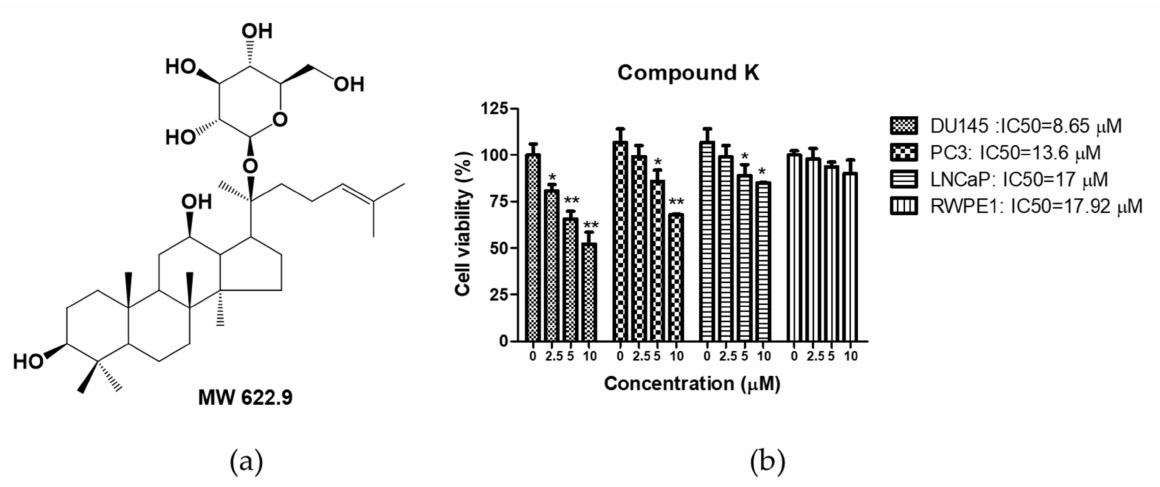
Figure 1. Effect of compound K on cytotoxicity in DU145, PC3 and LNCaP cells. ( a ) Chemical structure of compound K (CK). Molecular weight = 622.9 ( b ) DU145, PC3, LNCaP and RWPE1 cells were treated with various concentrations of CK (0, 2.5, 5 and 10 µ M) for 24 h, and cell viability was evaluated by MTT assay. Data represent means ± SD. * p < 0.05, ** p < 0.01 versus untreated